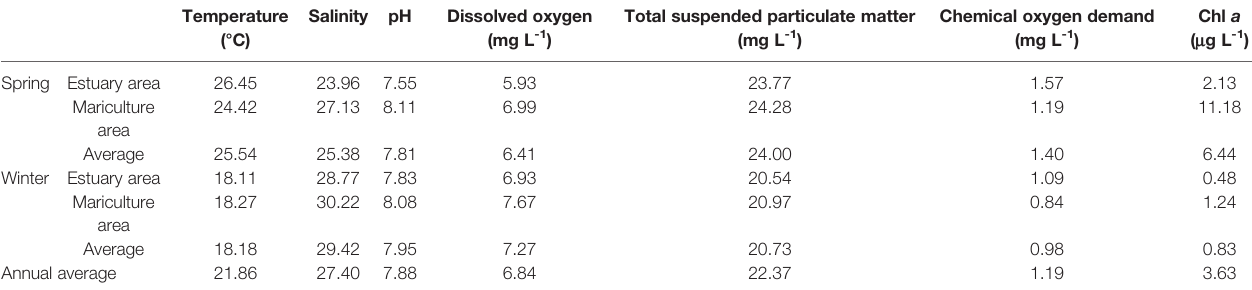
TABLE 1 | Summary of the average values of physico-chemical parameters in the seawater of different areas during spring and winter.